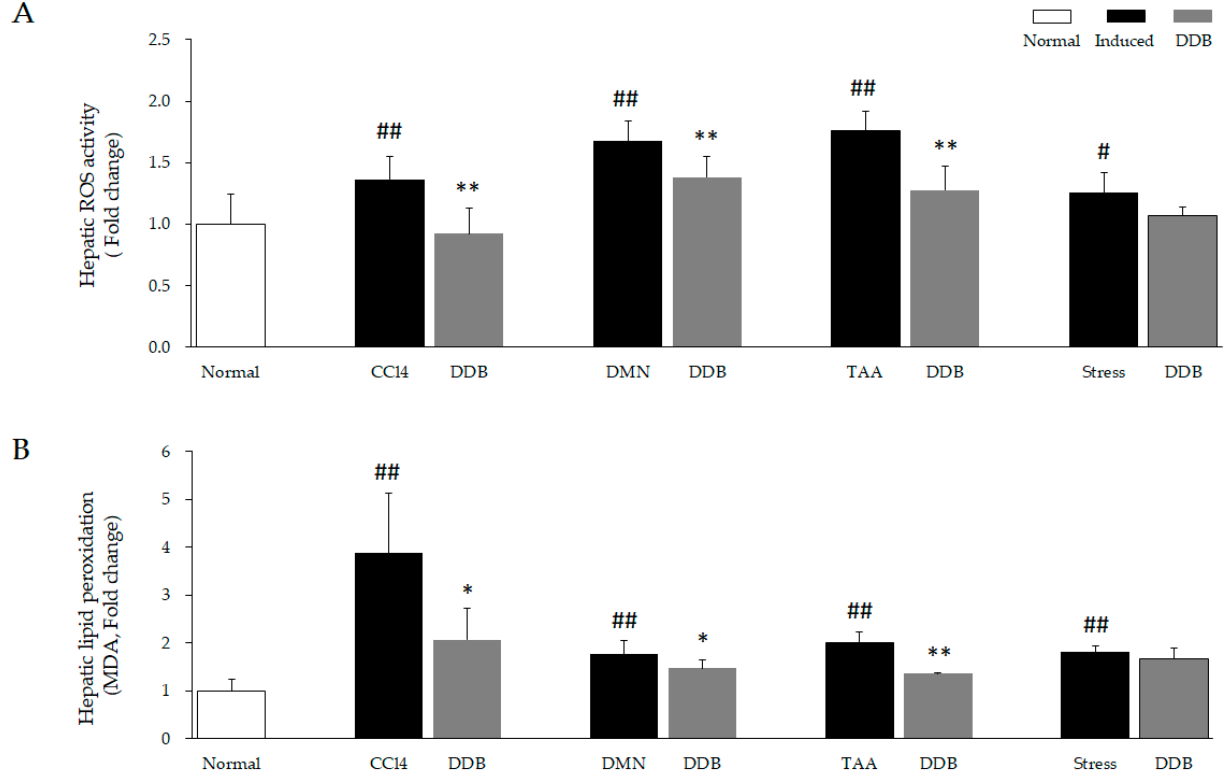
Figure 3. Comparison of hepatic ROS activity and lipid peroxidation in four liver injury models. Two oxidative stress parameters, reactive oxygen species ( A ) and malondialdehyde (MDA, a marker of lipid peroxidation) ( B ), were determined in prepared liver tissue samples. # p < 0.05 and ## p < 0.01 compared with the Normal group. * p < 0.05 and ** p < 0.01 compared with the corresponding control.